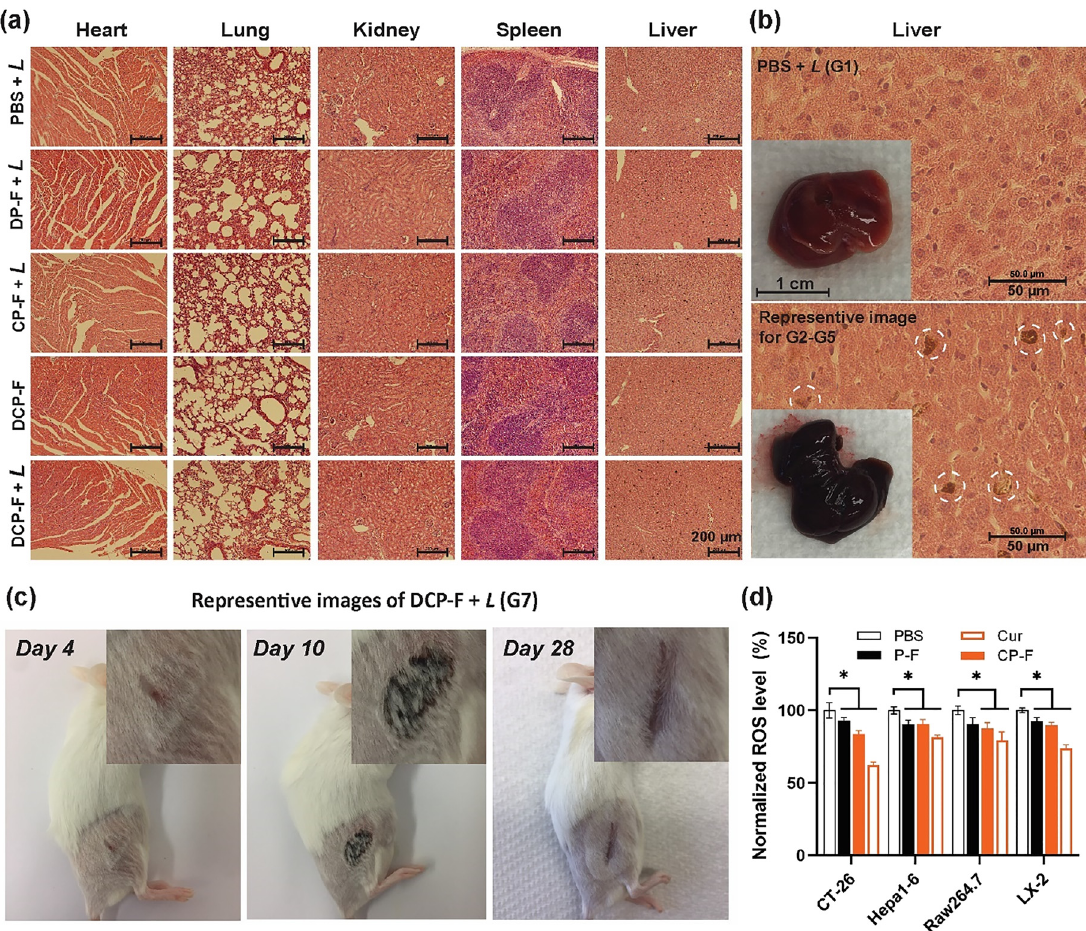
Figure 7: Safety evaluation of different treatments. (a) and (b) H&E morphology images of major organs and (b) representative liver photographs; note that the white dashed circles indicate the black substances; (c) healing of skin injury within 28 days; and (d) intracellular ROS change of different cell lines after different